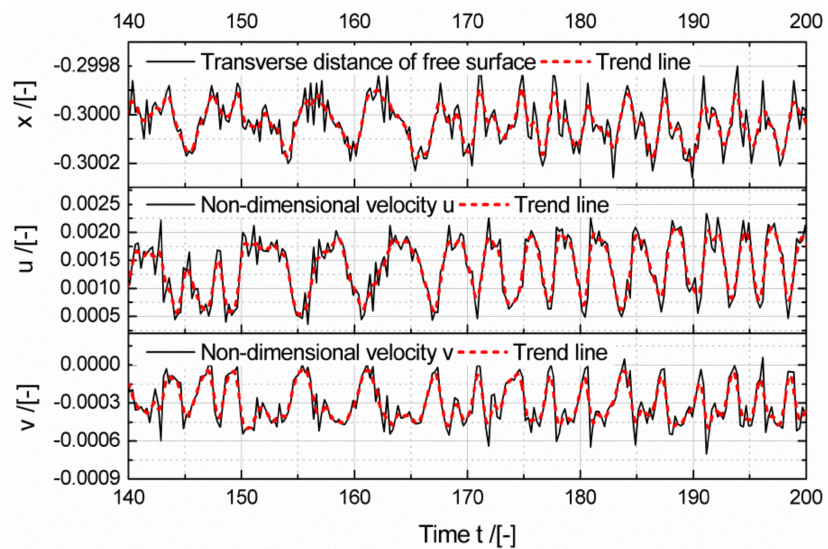
Figure 8. Oscillation of velocity and lateral displacement of monitoring point f on the free surface of corner area ( Ca C = − 0.01, R = 2.5 mm, H/R = 1.0, Vr =